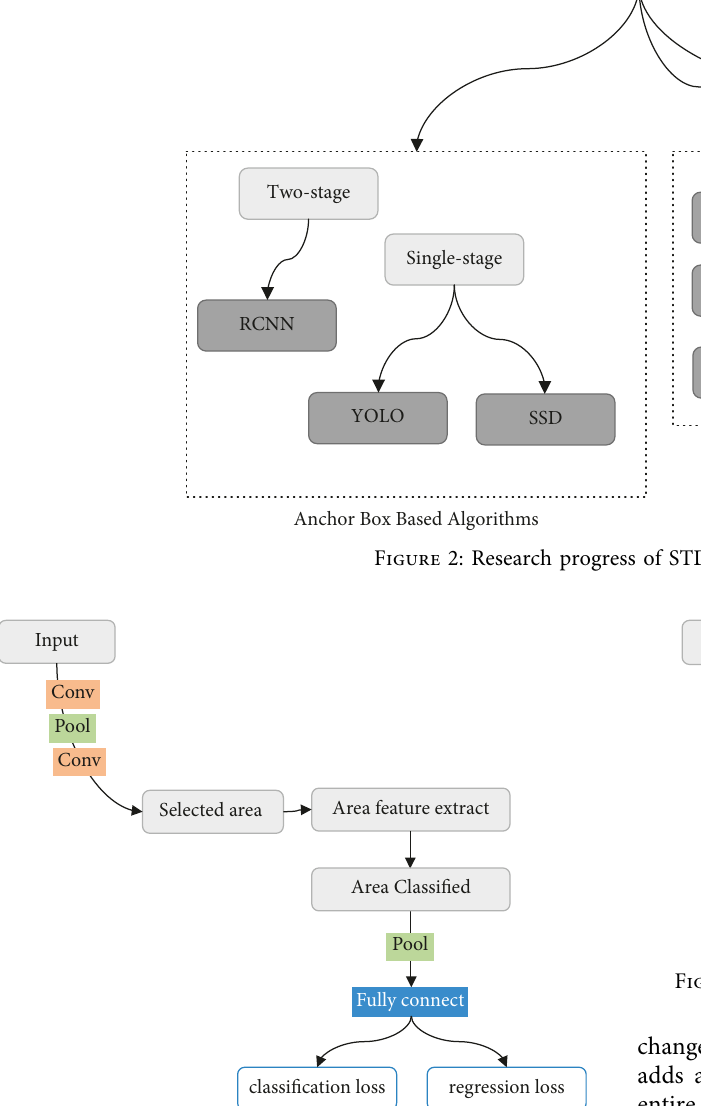
Figure 3: Two-stage class algorithm structure diagram.